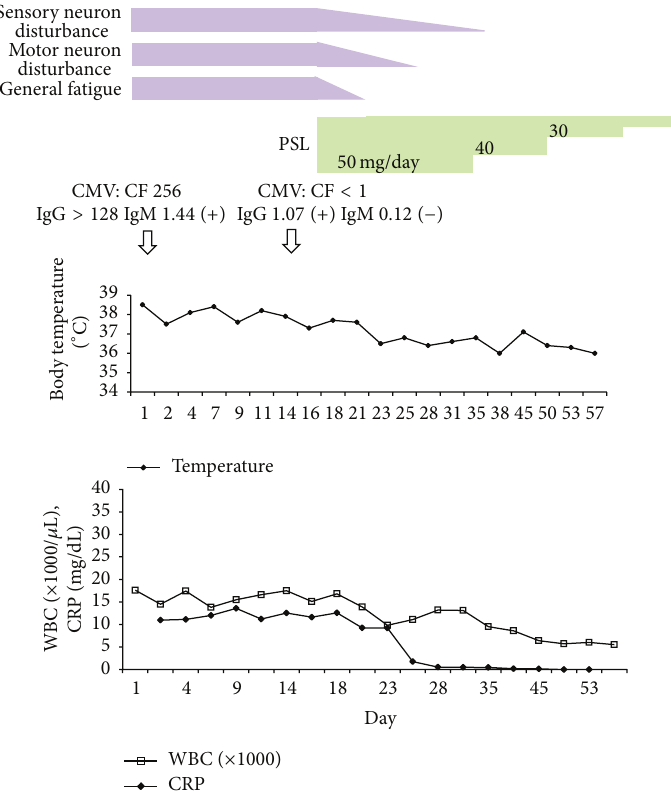
Figure 2: Clinical course of this case. After the diagnosis was made as PAN and CMV infection, he was given 50 mg of prednisolone and his symptoms were improved promptly and PSL dose could be